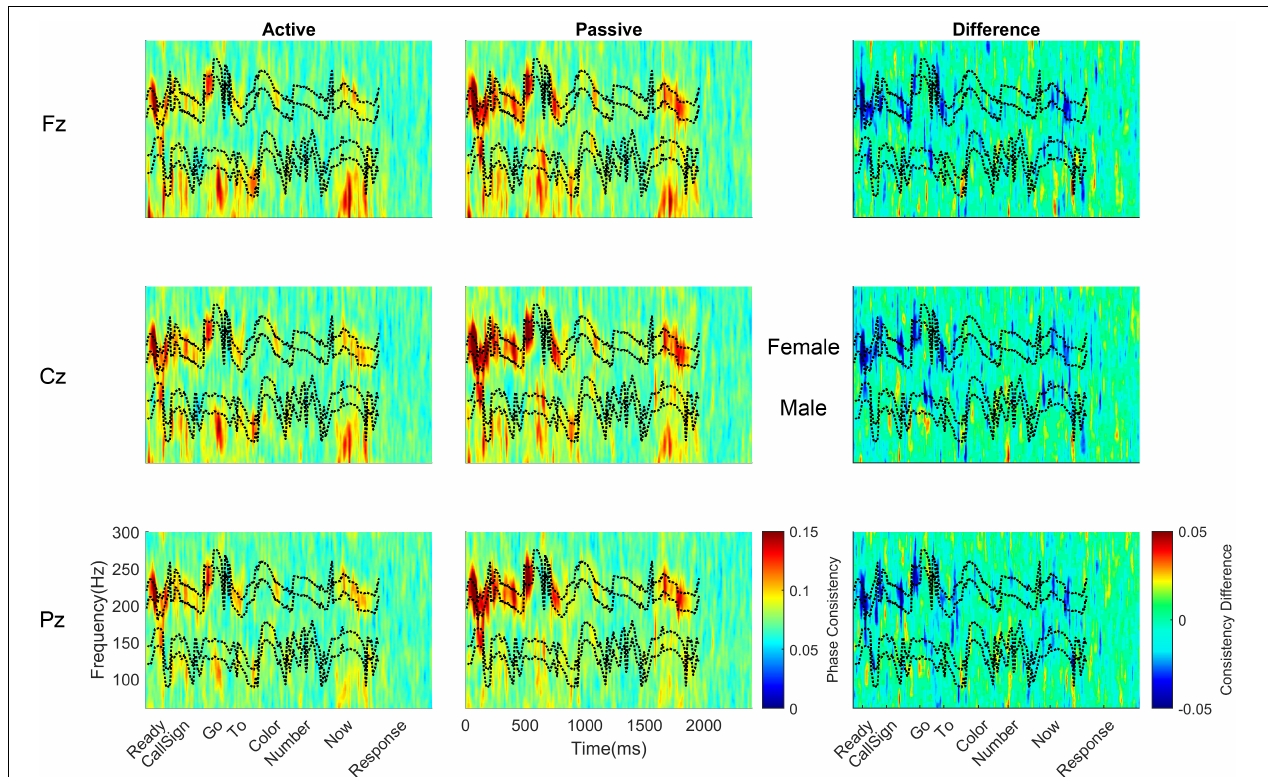
FIGURE 6 | Bilingual subcortical phase consistency. Bilingual phase consistency is plotted at Fz (top) , Cz (middle) , and Pz (bottom) for active (left) and passive (center) listening conditions. For these six plots, color represents greater phase consistency, with warmer colors indicating greater consistency and cooler colors representing little to no consistency. The rightmost plots show the difference in phase consistency between active and passive listening conditions, with warmer colors indicating greater consistency during active listening and cooler colors indicating more consistency during passive listening. The top two black dashed lines in each plot indicate the female pitch contour + 10 Hz and the bottom two dashed lines indicate the male pitch contour + 10 Hz (labeled between the passive and difference plots for Cz). Note that the regions that have multiple words (e.g., number) have no phase-locking while phase-locking consistency is evident over the words that are identical across trials (i.e., ‘ready,’ ‘go,’ ‘to,’ and ‘now’). Similar to monolinguals, active listening led to a decline in phase consistency in the subcortical response. However, across both passive and active listening conditions, bilinguals had higher subcortical phase consistency than